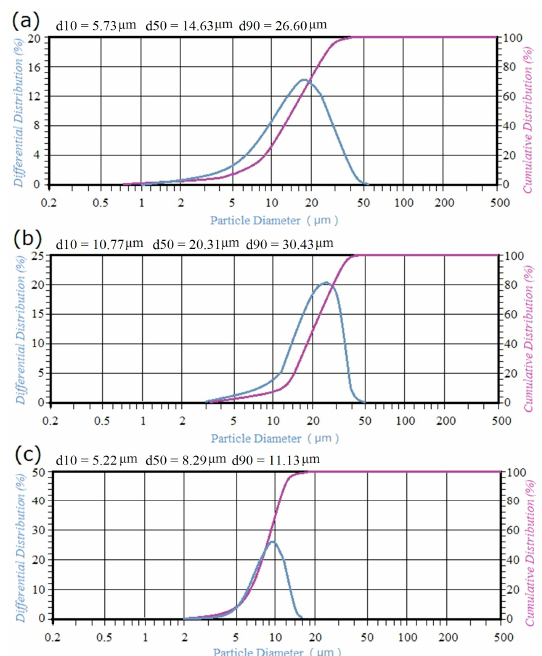
Figure 1. Size distributions of three kinds of SS316L powders ( a ) raw powder, ( b ) coarse powder and ( c ) fine powder.